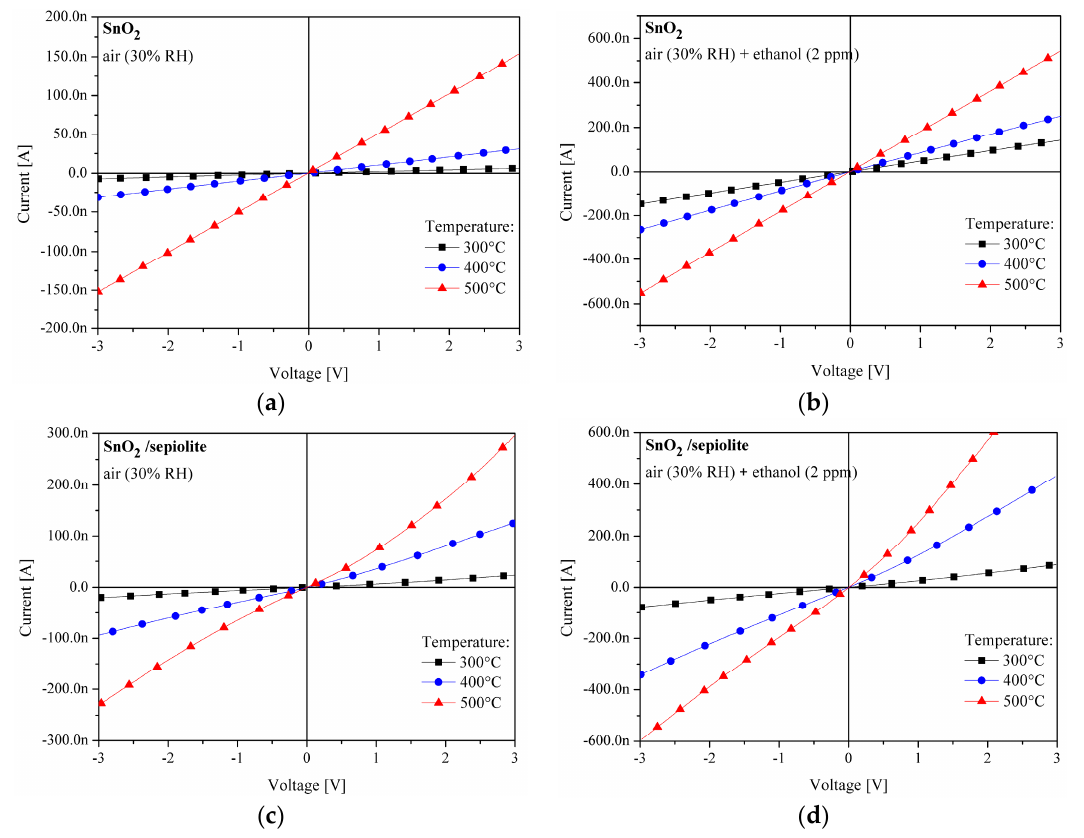
Figure 8. Current-voltage characteristics of the resistive gas sensor; ( a ) SnO 2 in air (30% RH); ( b ) SnO 2 in 2 ppm ethanol+air (30% RH); ( c ) SnO 2 /sepiolite in air (30% RH); ( d ) SnO 2 /sepiolite in 2 ppm ethanol + air (30% RH). Δ U = 150 mV/s.